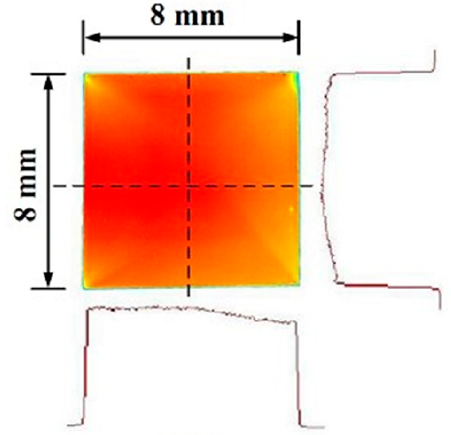
Figure 2. Pump light distribution.